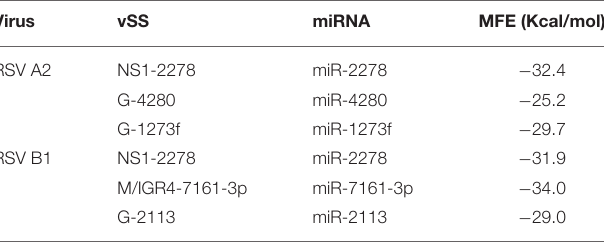
TABLE 1 | Binding energy calculations for vSSs per RNA duplex. Virus